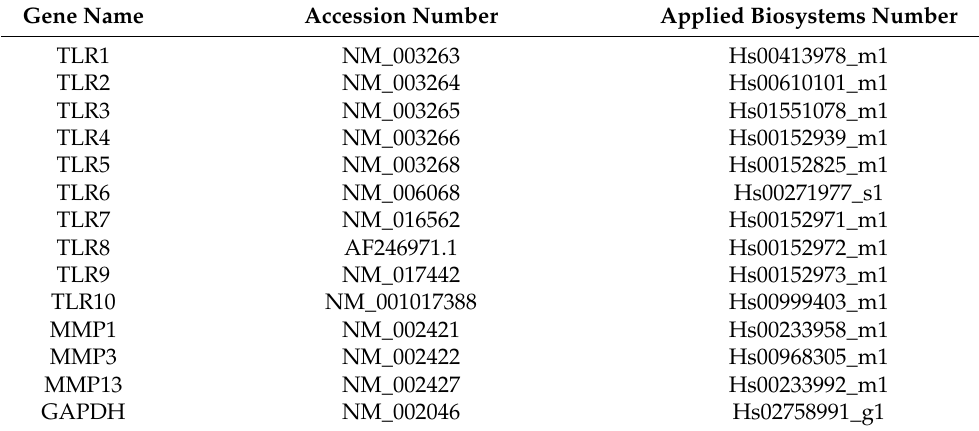
Table 1. TaqMan probes for gene expression